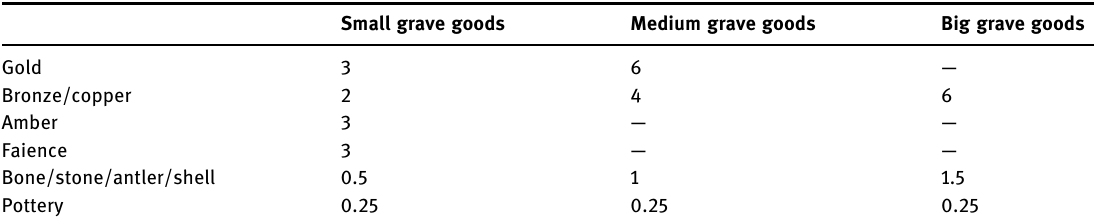
Table 3: Values of grave goods according to their grave goods category and raw